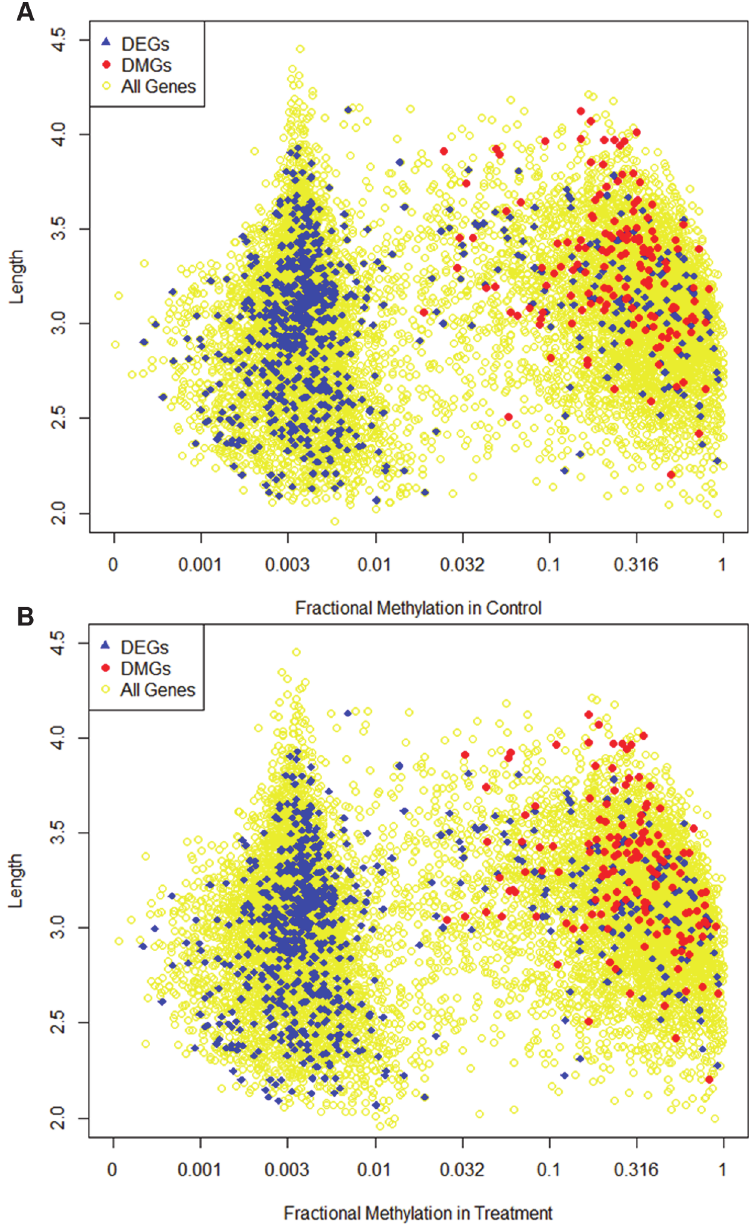
Fig 7. Dispersion of fractional methylation. Different characteristics of differentially methylated genes (DMGs) and differentially expressed genes (DEGs) are shown in the figure. The x-axis is the fractional methylation of genes in control (A) or treatment (B) shown in log-scale. The y axis is gene length in log-scale. Genes longer than 10000 (1735 genes in total, 53 DEGs, 0 DMGs) are not shown in the figure. The yellow circles represent the background showing the distribution of methylation and length for all genes. Blue triangles represent the DEGs (identical between figures) and red dots represent the